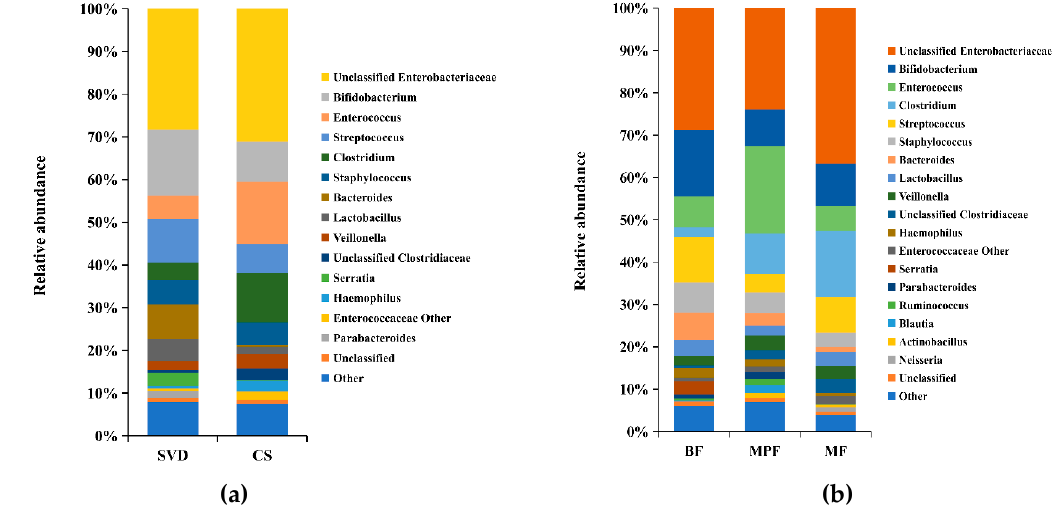
Figure 2. Composition of infant gut microbiota at the genus level in different delivery modes and feeding methods. ( a ) Delivery modes; ( b ) Feeding methods. Showing genera found at >1% average in total population. Genera found at <1% were grouped as “other”.